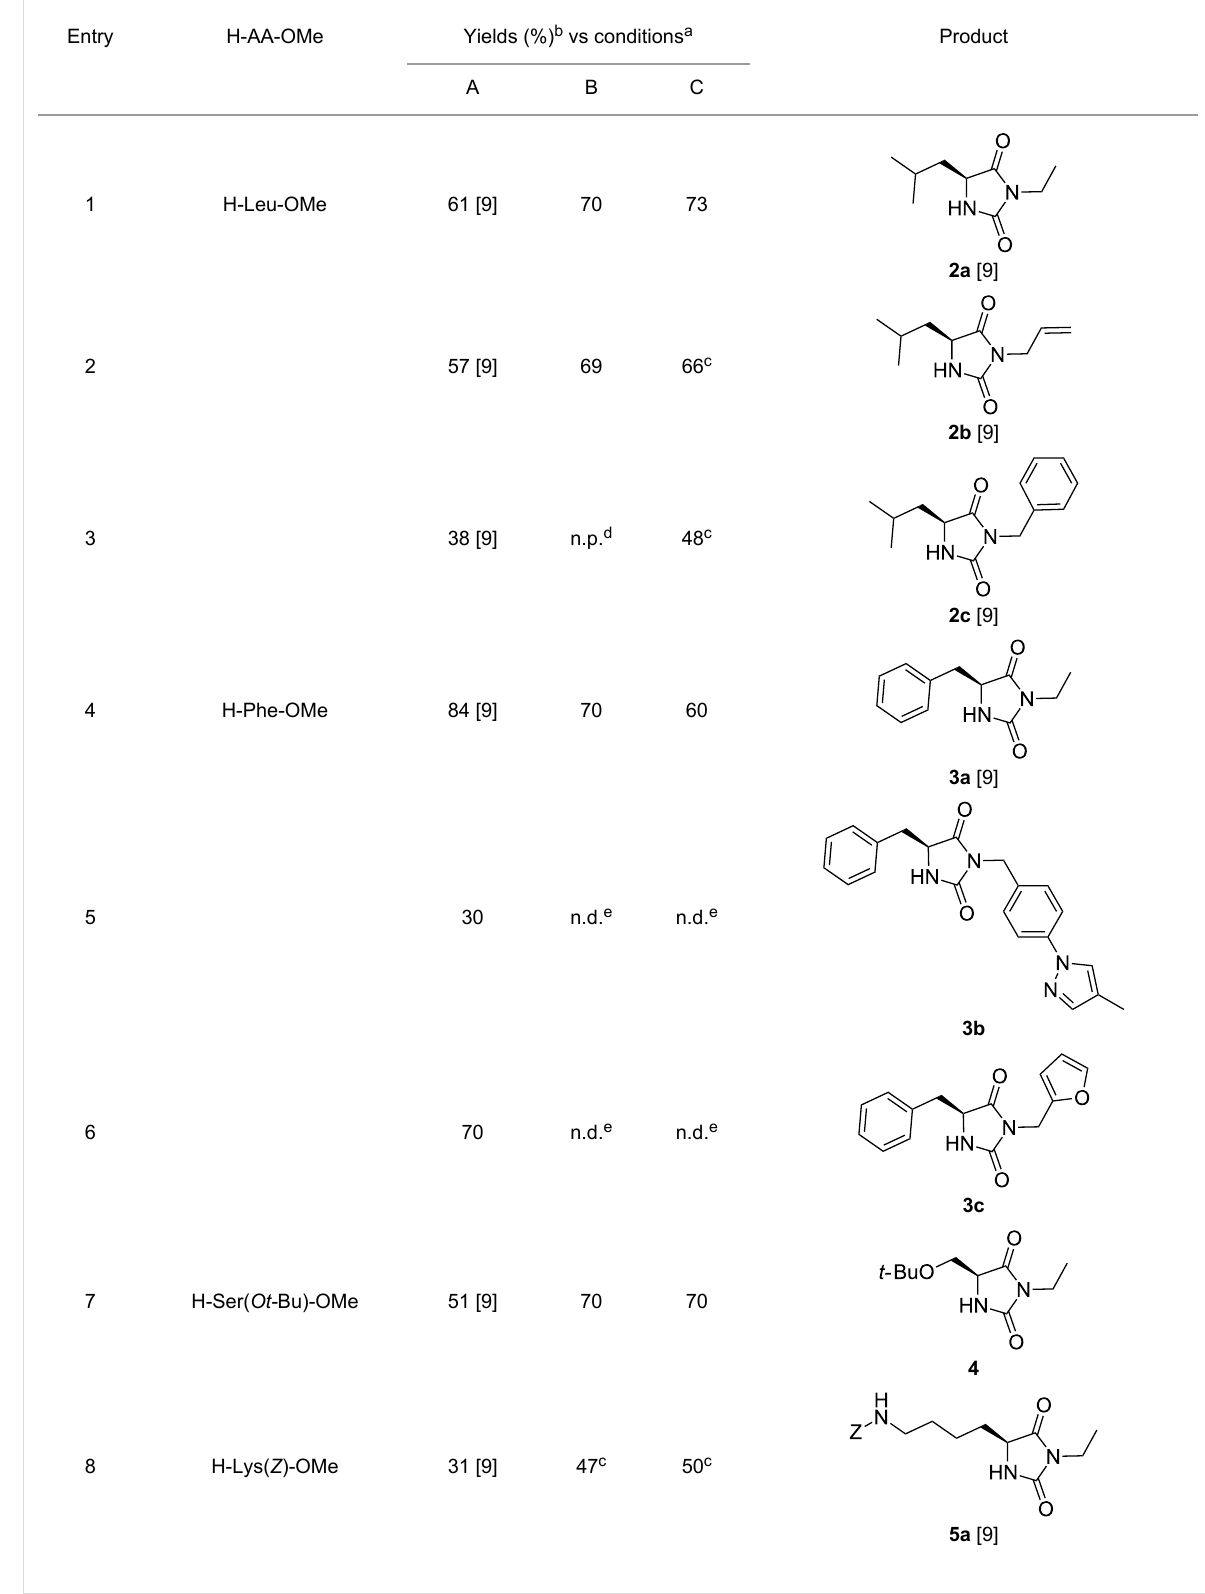
Table 3: Syntheses of 3,5-disubstituted hydantoins under dry-grinding (conditions A) a or PEG-assisted grinding (conditions B and C).